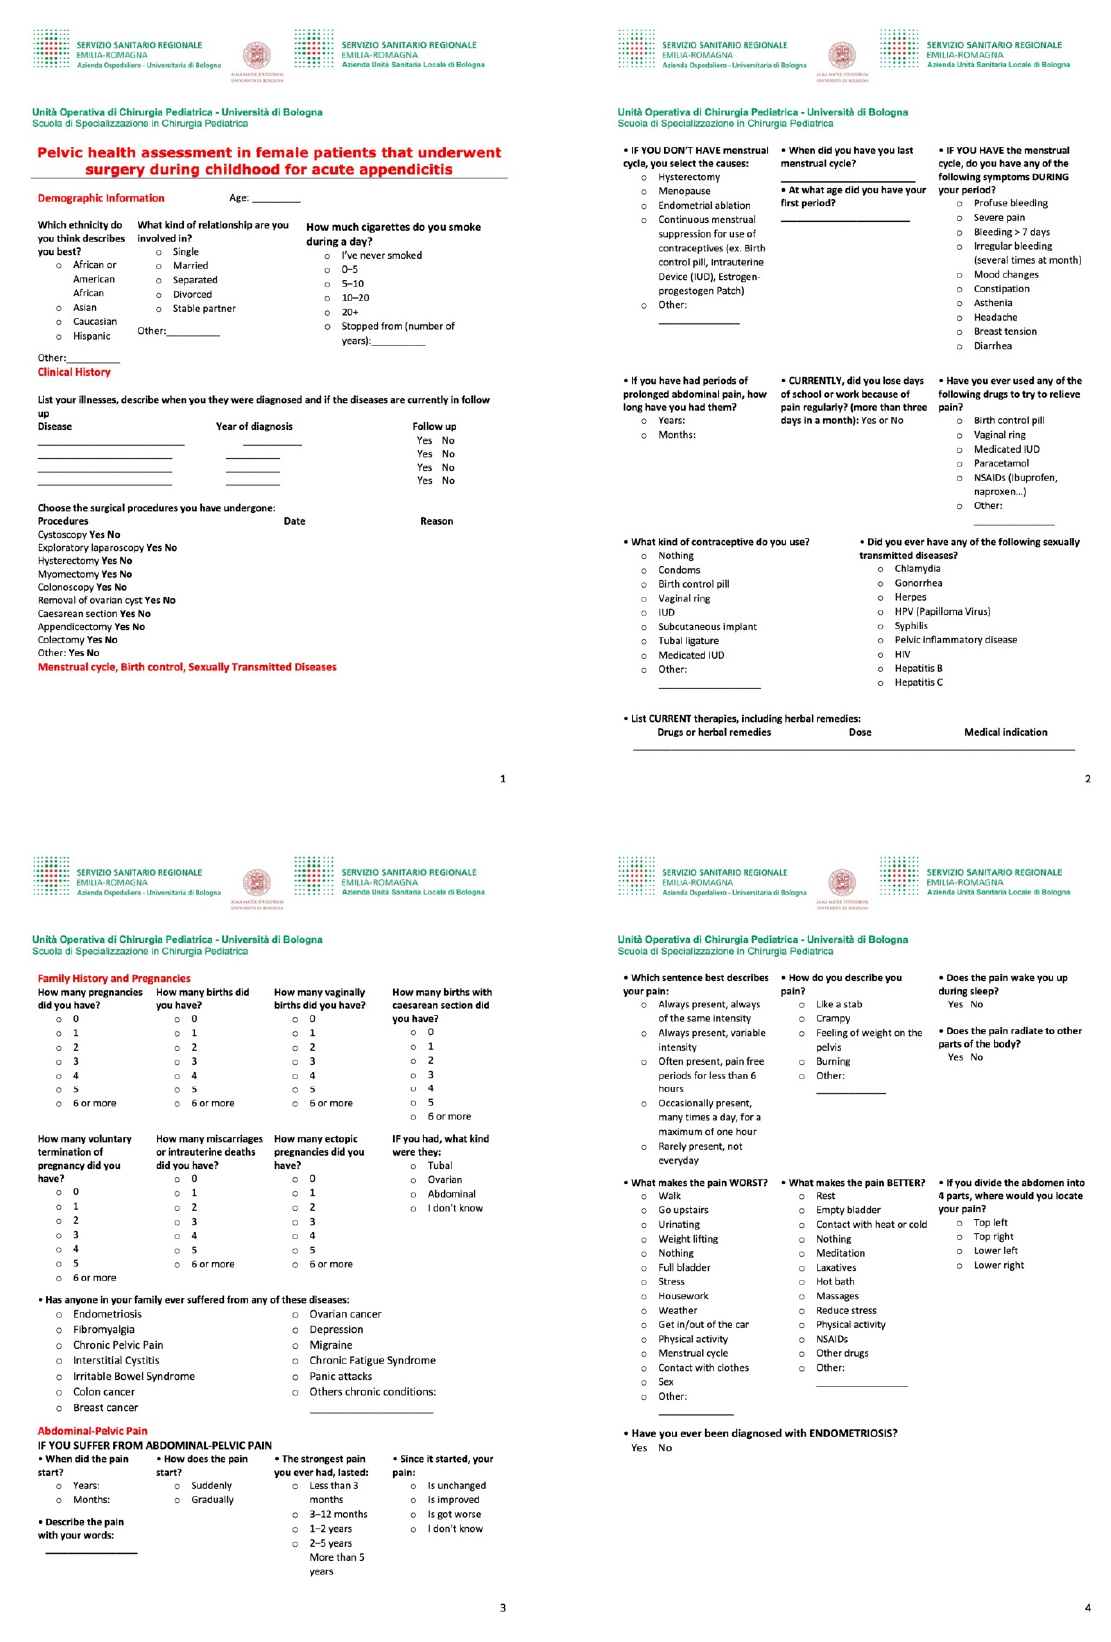
Figure 1. Questionnaire administered to the patients: detailed ob-gyn anamnestic form .